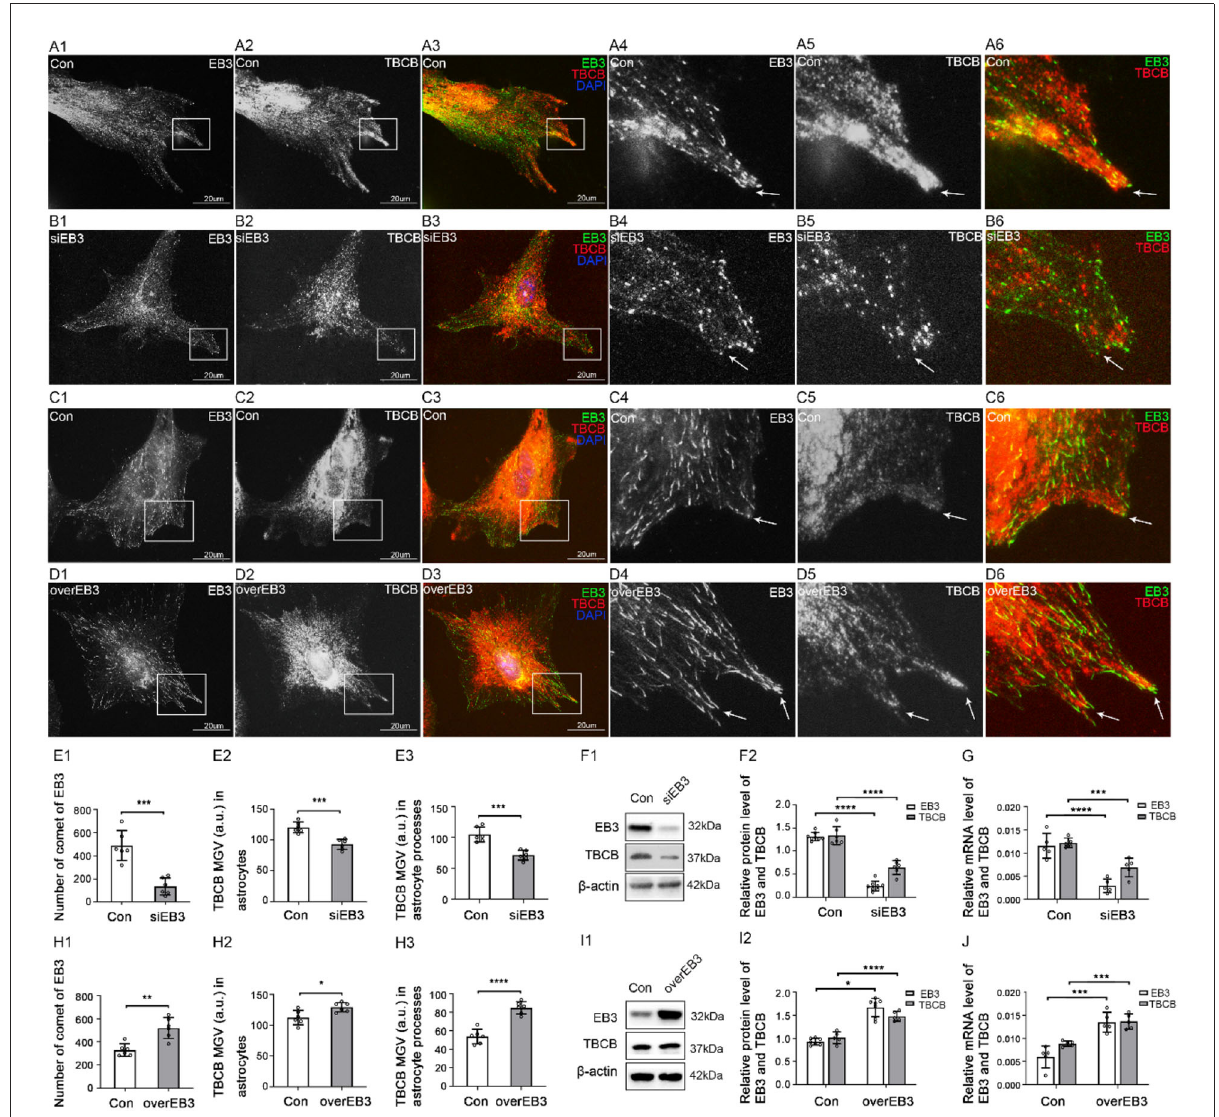
FIGURE5 The expression of TBCB after EB3 was silenced or overexpressed in astrocytes. (A–D) Immunofluorescence showed that EB3 [ (A–D) green signal] was co-expressed with TBCB [ (A–D) red signal] in astrocytes both in the control group [Con (A,C) ] and EB3 silence group (B) or EB3 overexpression group (D) . (E,H) The number of EB3 comets and mean gray value (MGV) of TBCB in astrocytes and its processes (MGV = Integrated Density/Area) after EB3 was silenced or overexpressed. (F,I) Western blot and (G,J) RT-PCR analysis of protein and mRNA levels of EB3 and TBCB after EB3 was silenced or overexpressed compared with the control group ( n = 6, p < 0.05). (A–J) Number of panels. * p < 0.05, ** p < 0.01, *** p < 0.001, **** p <